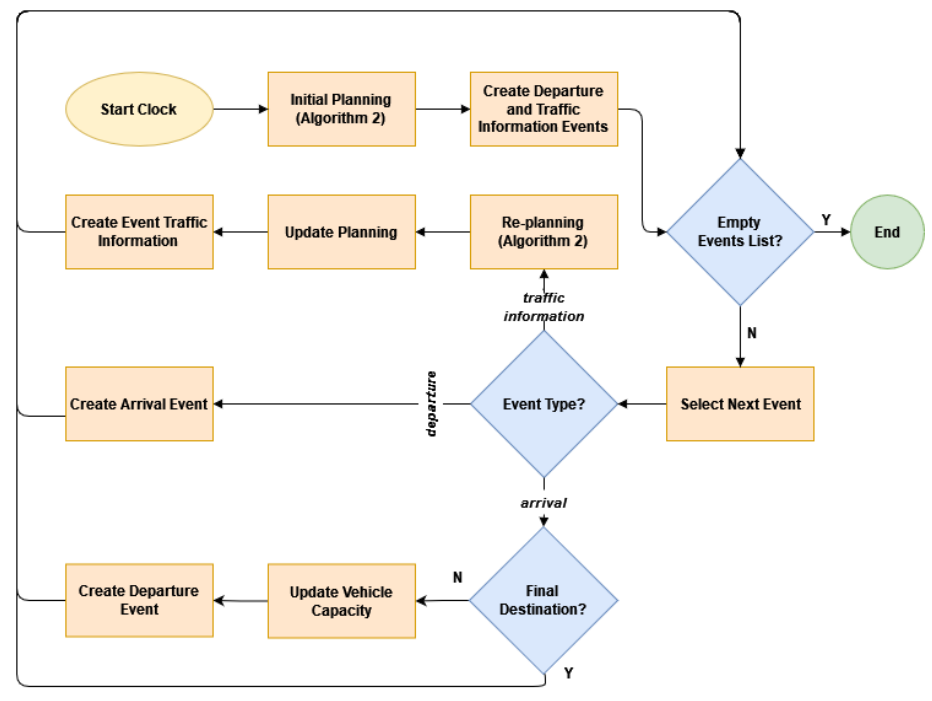
Figure 4. Discrete-Event Algorithm